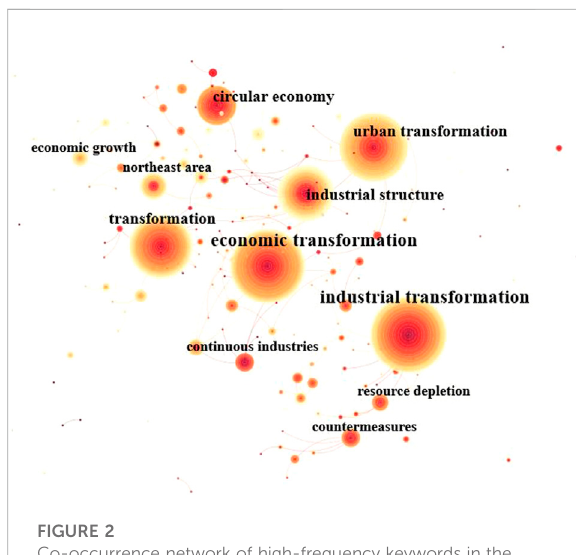
FIGURE 2 Co-occurrence network of high-frequency keywords in the CNKI